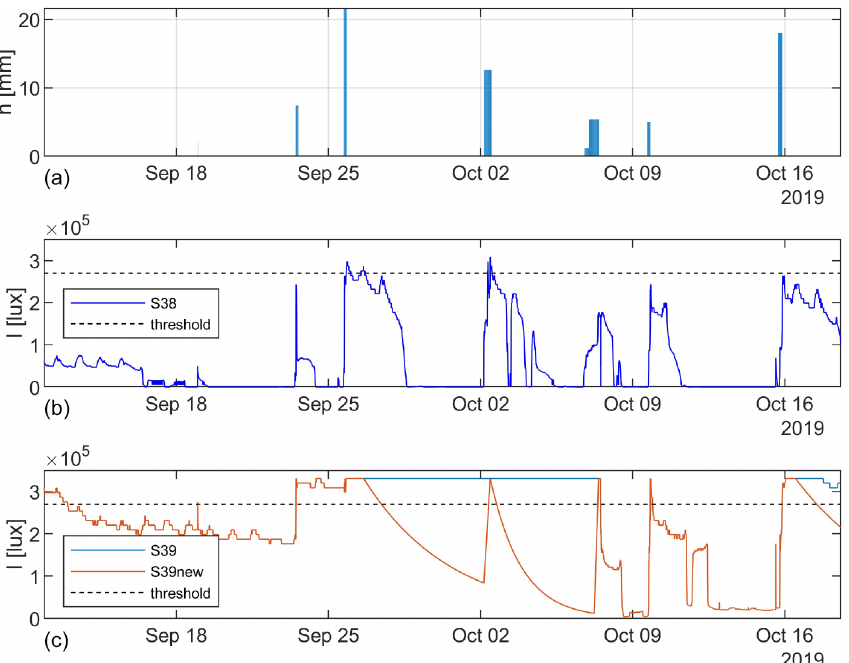
Figure B2. (a) Hyetograph of the period during which the corrections to S 39 were applied. (b) Time series of S 38 . (c) Time series of S 39 before the corrections (light blue) and after the corrections